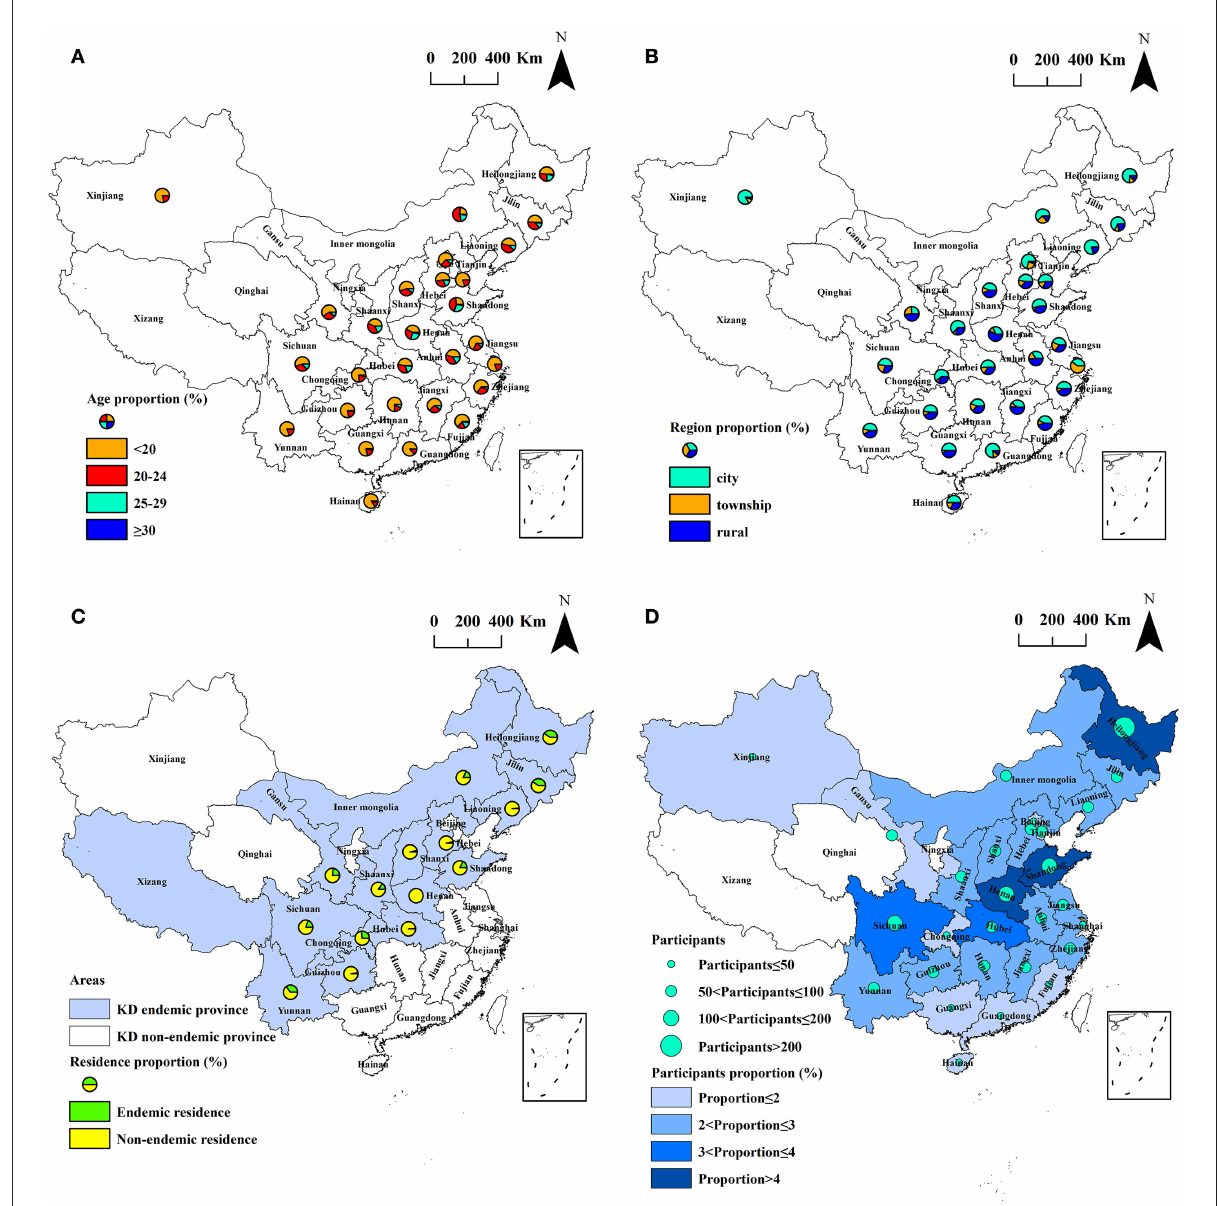
FIGURE2 The spatial distribution of the participants by province. (A) Age; (B) region; (C) residence in[[Inline Image]] KD endemic province; and (D) participants and its